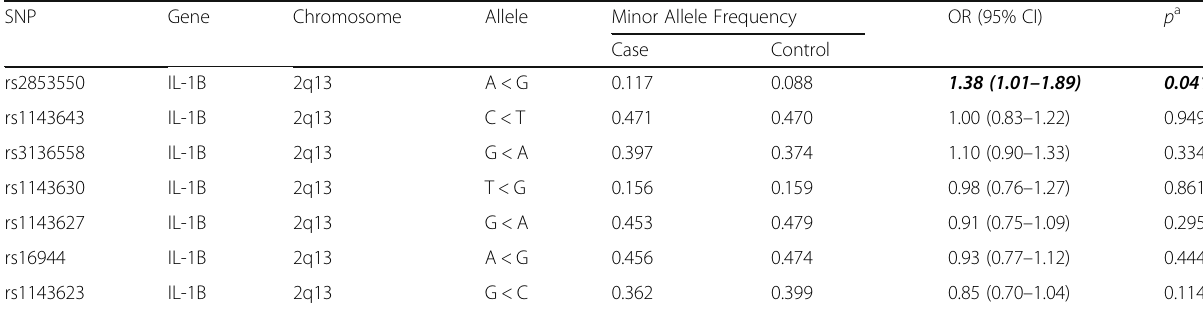
Table 2 Basic characteristics and allele frequencies of the seven IL-1B SNPs SNP Gene Chromosome